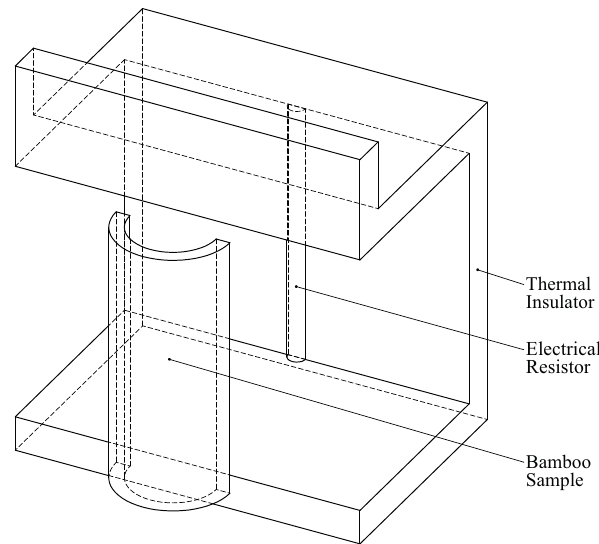
Figure 5. Experimental measurement